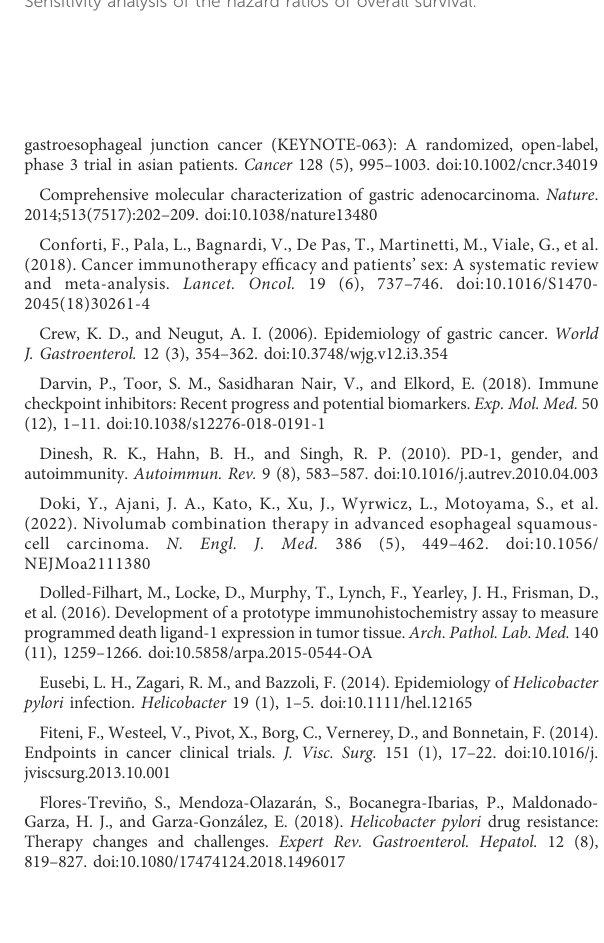
SUPPLEMENTARY FIGURE S3 The p value of Begg ’ s funnel plots for publication bias. SUPPLEMENTARY FIGURE S4 Sensitivity analysis of the hazard ratios of overall